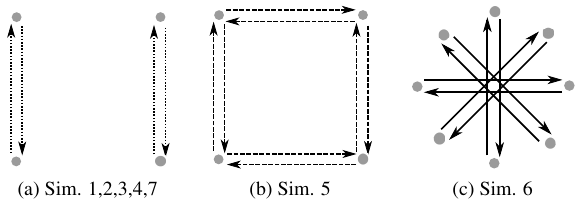
Figure 6: The three flight configurations investigated in this study are visualized in a top view. Each line is sampled in both direc- tions, resulting in an image overlap of approximately 100% .